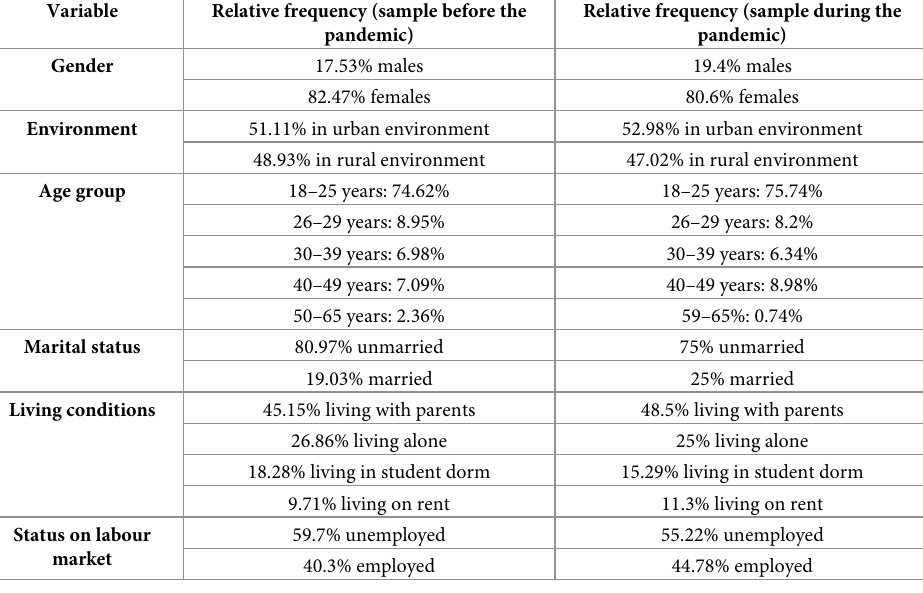
Table 1. Samples’ characteristics (before and during the